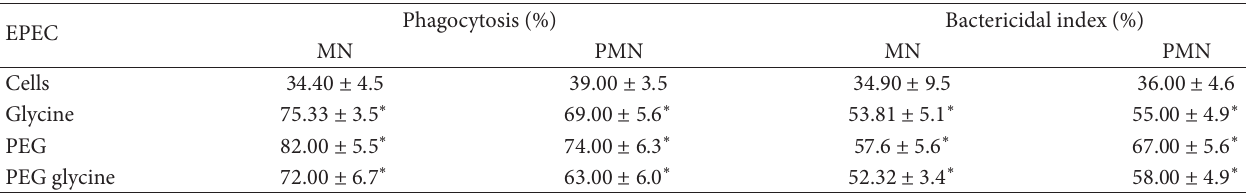
Table 2: Bacterial phagocytosis and bactericidal activity index by mononuclear (MN) and polymorphonuclear (PMN) cells (mean ± SD, 𝑁 = 10 in each treatment).